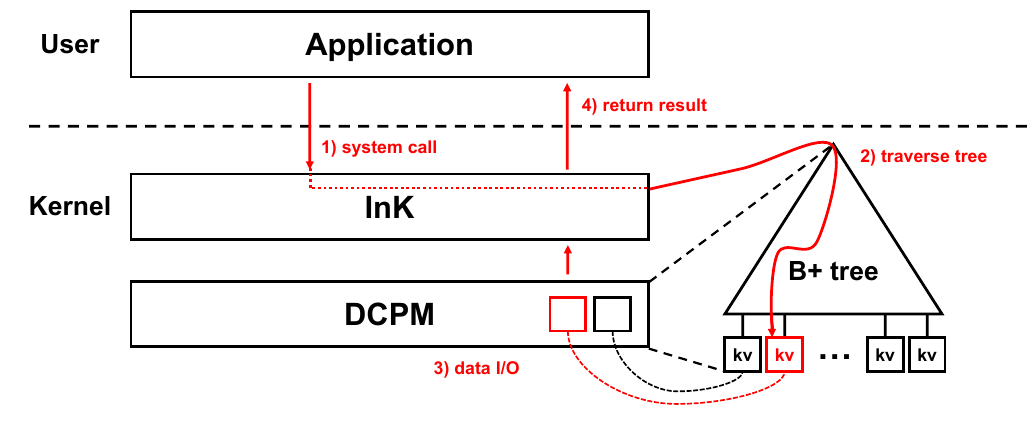
Figure 1. The overall architecture of InK